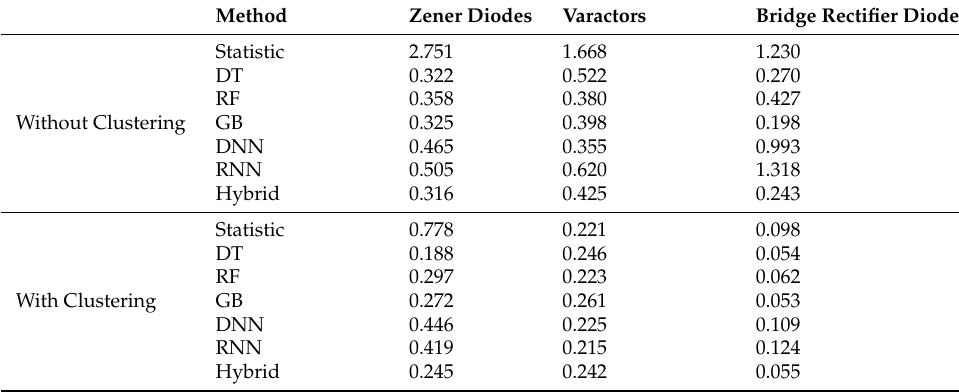
Figure 15. RMSRE of the test data with and without clustering for ( a ) Zener diodes, ( b ) varactors, and ( c ) bridge rectifier diodes. Table 11. RMSRE of the test data with and without